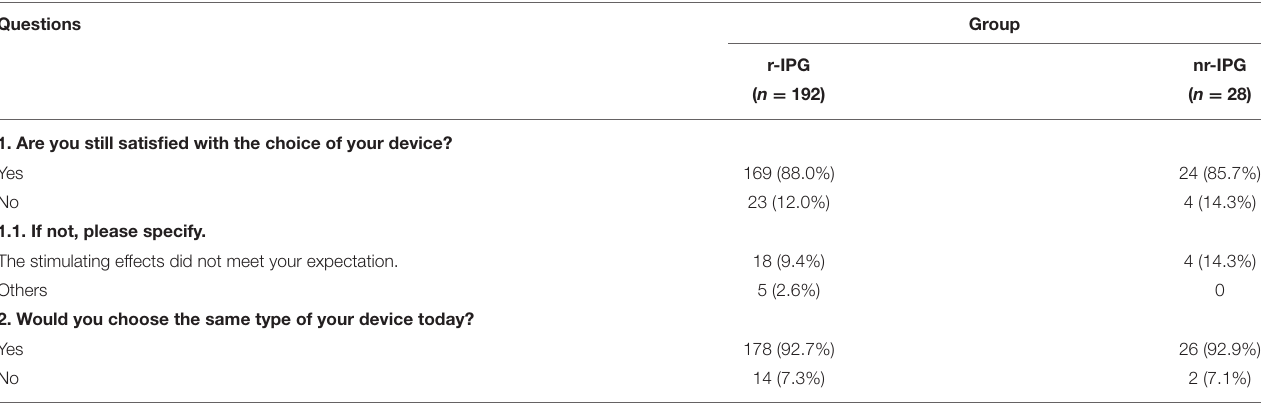
TABLE 2 | Patient satisfaction as a function of the type of IPG ( N =